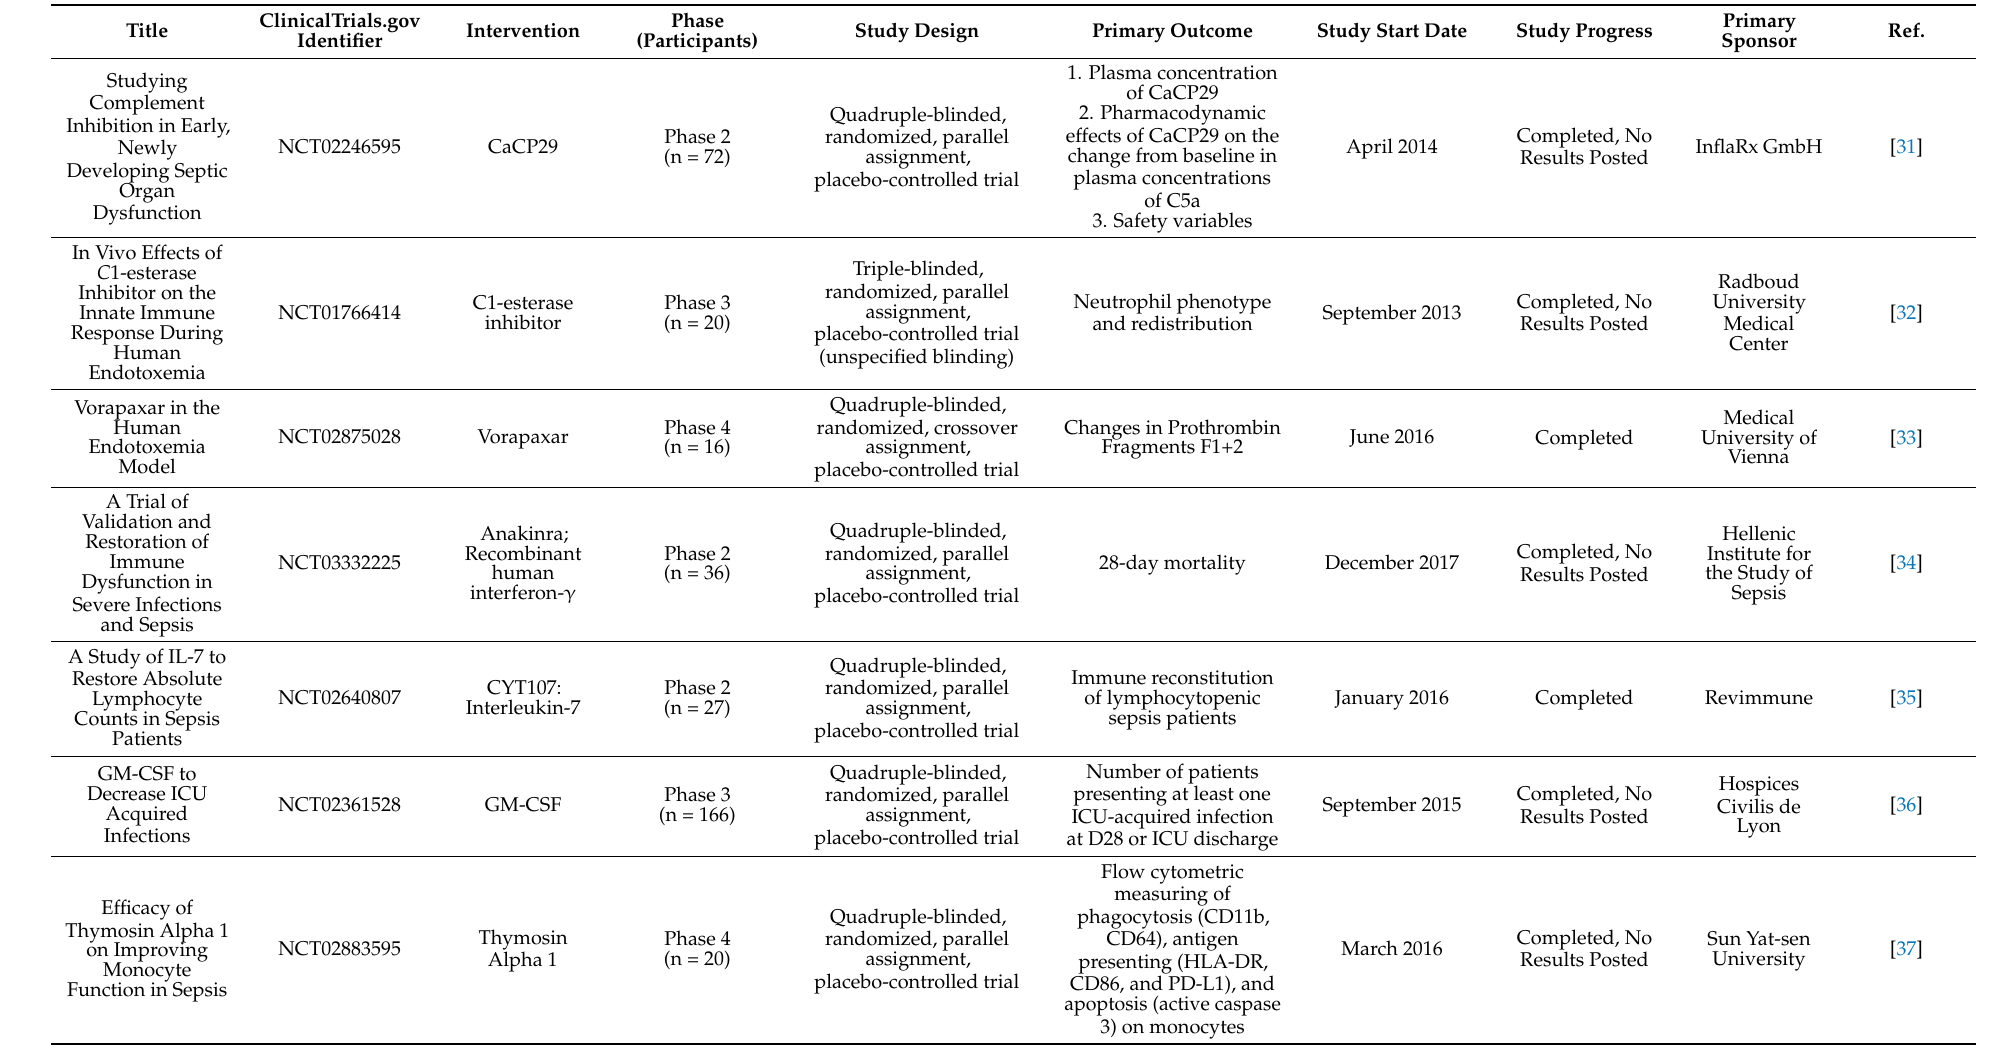
Table 1. Completed interventional studies for the treatment of sepsis and septic shock from the last 10